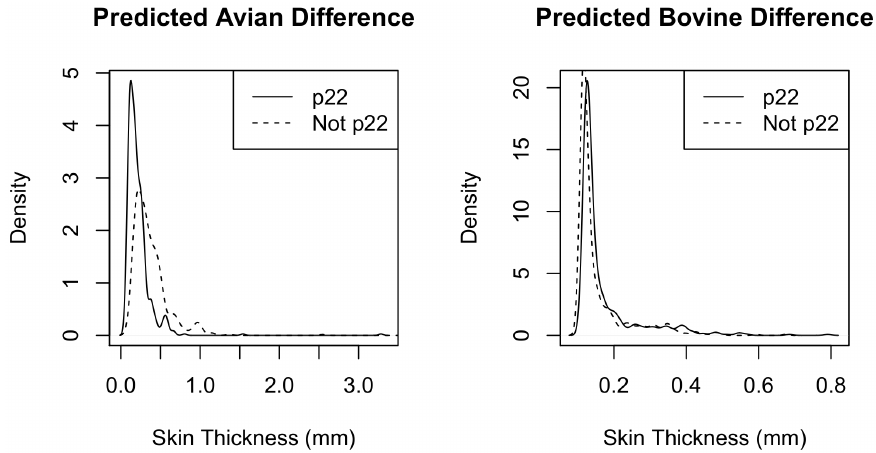
Figure 2. Predicted effect of ‘22’ genotypeon the swellinginduced by avian and bovinetuberculin challenges. Swelling size is taken as the difference between the initial measurement, taken immediately following injection, and the final measurement, taken after the prescribed 72 hour time delay thatallows animmuneresponse tooccur (hereafter=‘difference’).This controlsforskinthicknessdifferencesbetweenanimals.Thegraphs showthe predicted impact of the ‘22’ parameter (0=not ‘22’, 1=‘22’) on the avian (da, left) and bovine ( db , right) differences. Predicted values are calculated from the respective zero-inflated regression models da , age + a 1 + p22, db , age + b1 + p22 described within the main text (summarised in Tables 3 and 4). The distribution of predicted values with (solid line) and without (dashed line) the ‘22’ genotype are compared as smoothed density curves. No effect was found for the bovine differences but the model predicts a smaller avian difference ( da ) when among animals with the ‘22’ genotype.